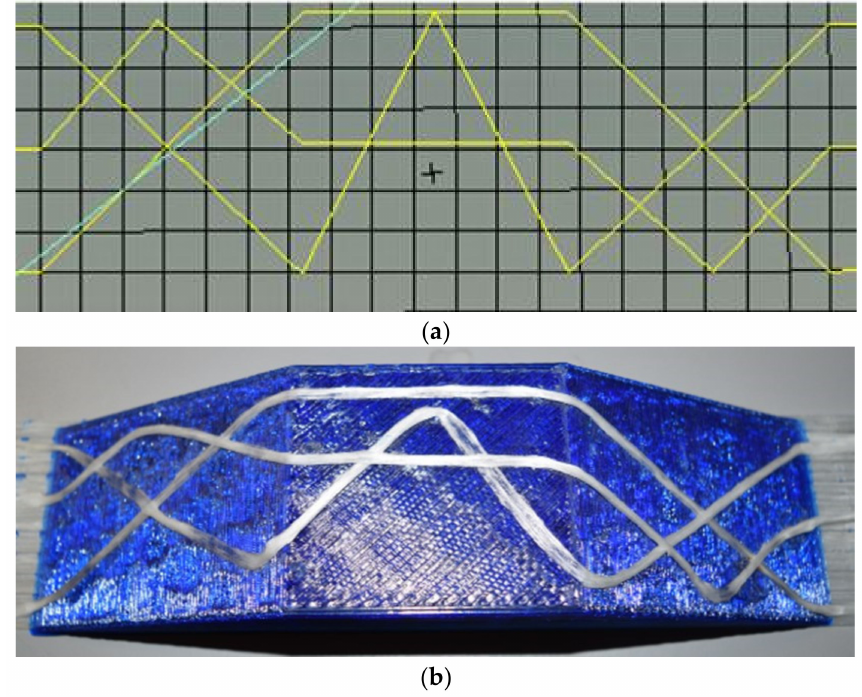
Figure 12. Non-linear placement